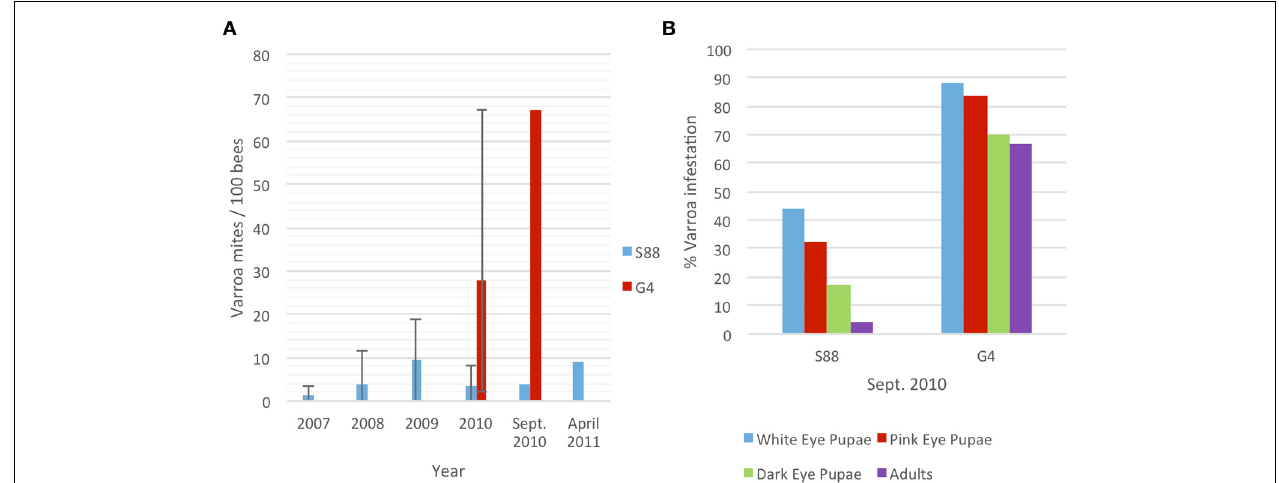
FIGURE 1 | Quantification of Varroa mite infestation of G4 and S88 bees. (A) Average phoretic Varroa infestations per 100 bees in S88 and G4 colonies. Bars show the range of yearly phoretic Varroa infestations in S88 (2007–2010)